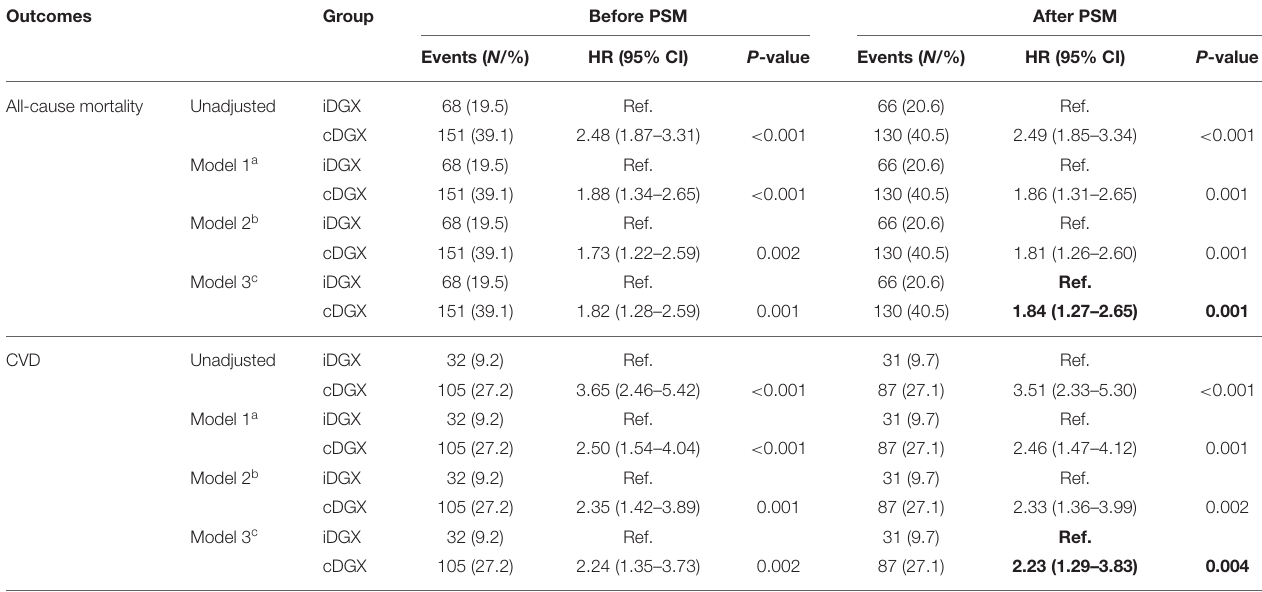
TABLE 3 | Association of DGX application methods with all-cause death and CVD in RHD patients. Outcomes